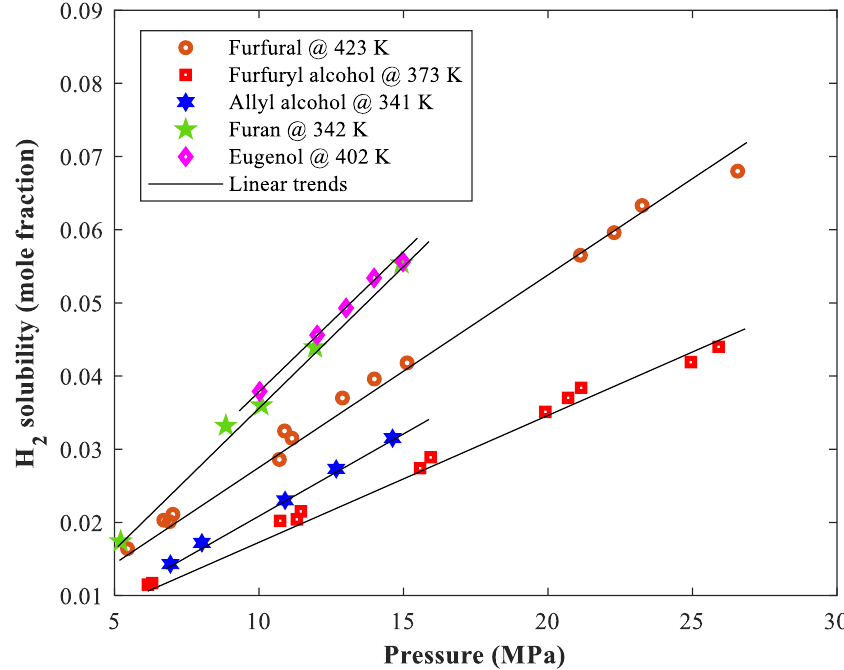
Figure 1. Hydrogen solubility in biomaterials versus working pressure.